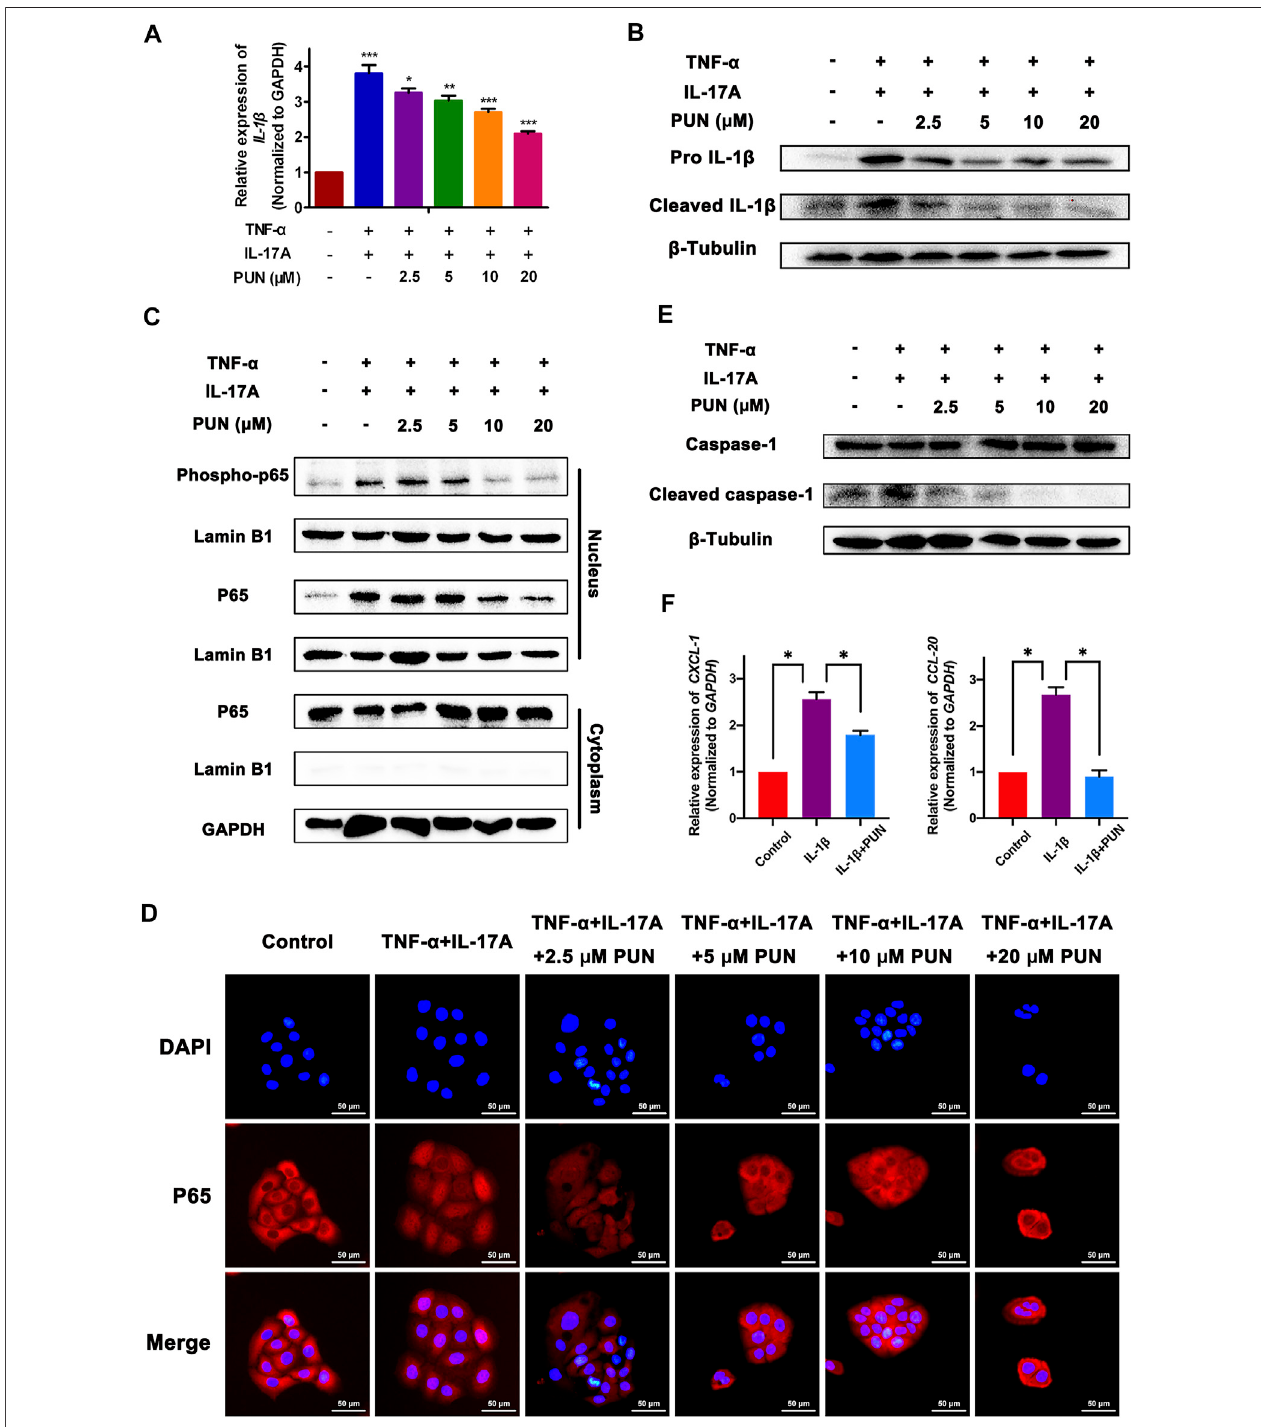
FIGURE2| PunicalaginsuppressestheTNF- α andIL-17A-inducedIL-1 β upregulation via inhibitingNF- κ Bactivationandcleavedcaspase-1expression invitro . (A) The relative mRNA level of IL-1 β indifferentgroups. Hereweused IL-17A(25 ng/ml) and TNF- α (25 ng/ml)tostimulate HaCaT cells.Simultaneously, wealso added 2.5/ 5/10/20 μ M PUN into these IL-17A and TNF- α -stimulated HaCaT cells. The total RNA was subsequently extracted after treatment with IL-17A (25 ng/ml) + TNF- α (25 ng/ml) and 2.5/5/10/20 μ M PUN for 24 h. (B) The pro- and mature expression of IL-1 β in different groups. The total protein was collected after treatment with IL-17A (25 ng/ml) + TNF- α (25 ng/ml) and 2.5/5/10/20 μ M PUN for 48 h. (C) The expression of phosphorylation (Ser536) and total p65 in the cytoplasm and nucleus after exposure of IL-17A (25 ng/ml) + TNF- α (25 ng/ml) and 2.5/5/10/20 μ M PUN for 24 h. (D) Immunostaining with an anti-p65 antibody showed that 2.5/5/10/20 μ M